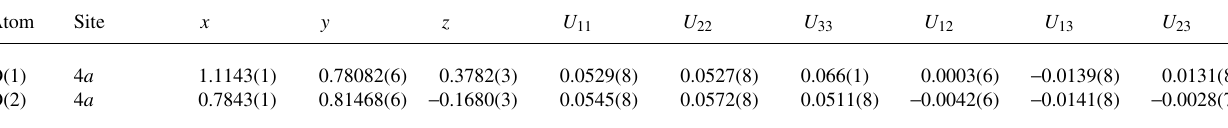
Table 3. Atomic coordinates and displacement parameters (in Å 2 ) .